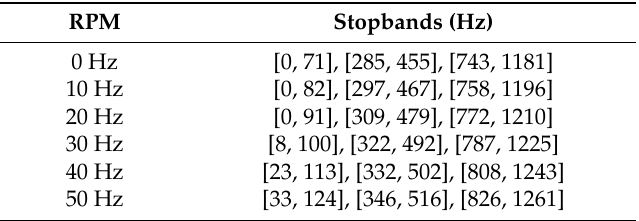
Table 7. Numerical stopbands derived from different rotating speeds.